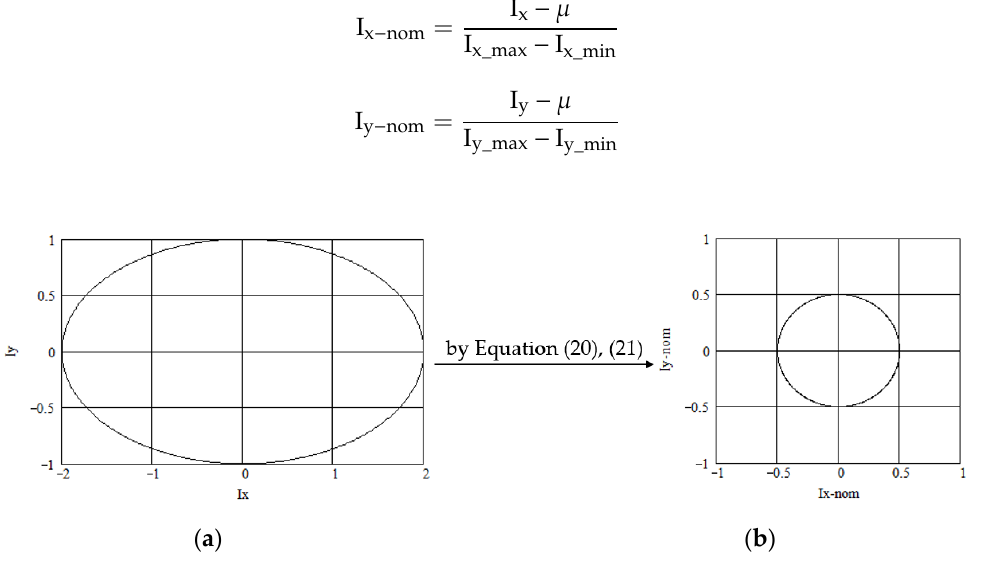
Figure 6. Assumed ellipse. ( a ) Original graph; ( b ) Graph with mean normalization processing.